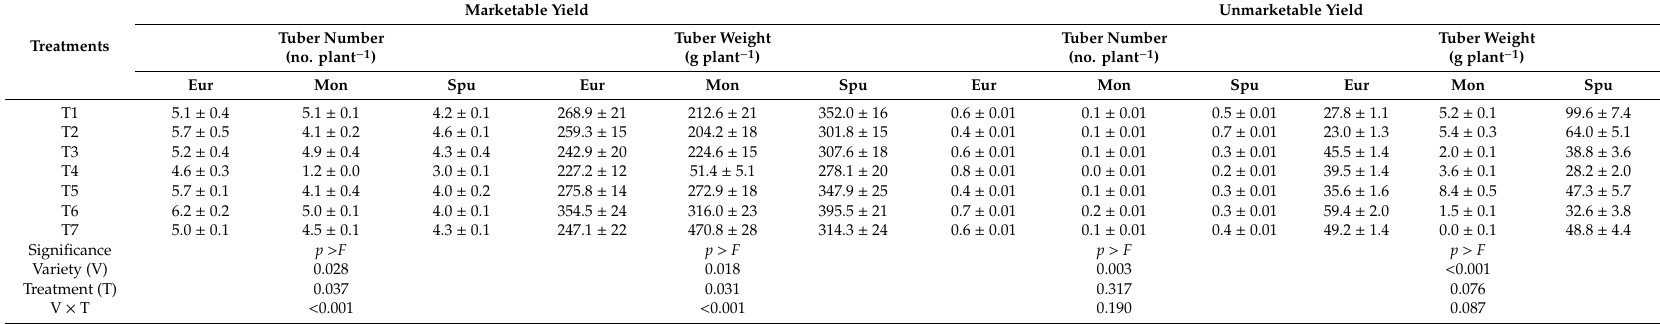
Table 8. Average ( ± standard error) marketable and unmarketable plant production (expressed as number and grams of tuber per plant) of three varieties (Europa, Monalisa, and Spunta) subjected to seven dormancy-breaking treatments applied during storage pre-planting condition (Experiment